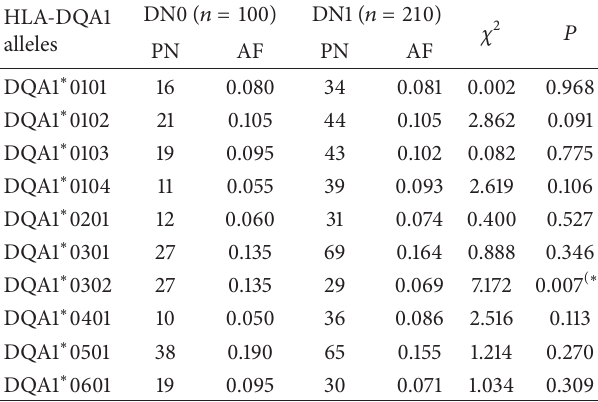
Table 5: Frequency of HLA-DQA1 alleles in T2DM patients with and without DN.